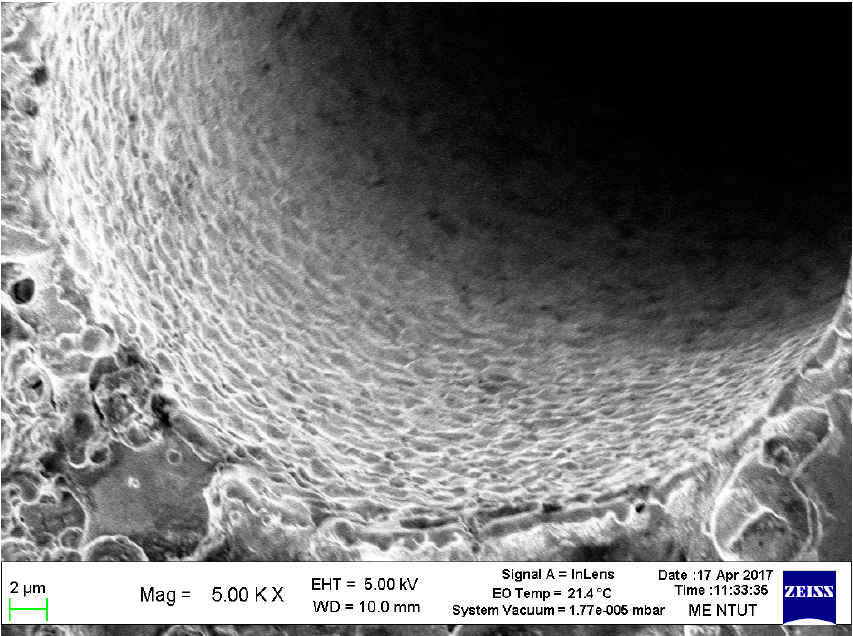
Figure 11. Surface of WC-Co micro-holes observed by Scanning Electron Microscope ( SEM).